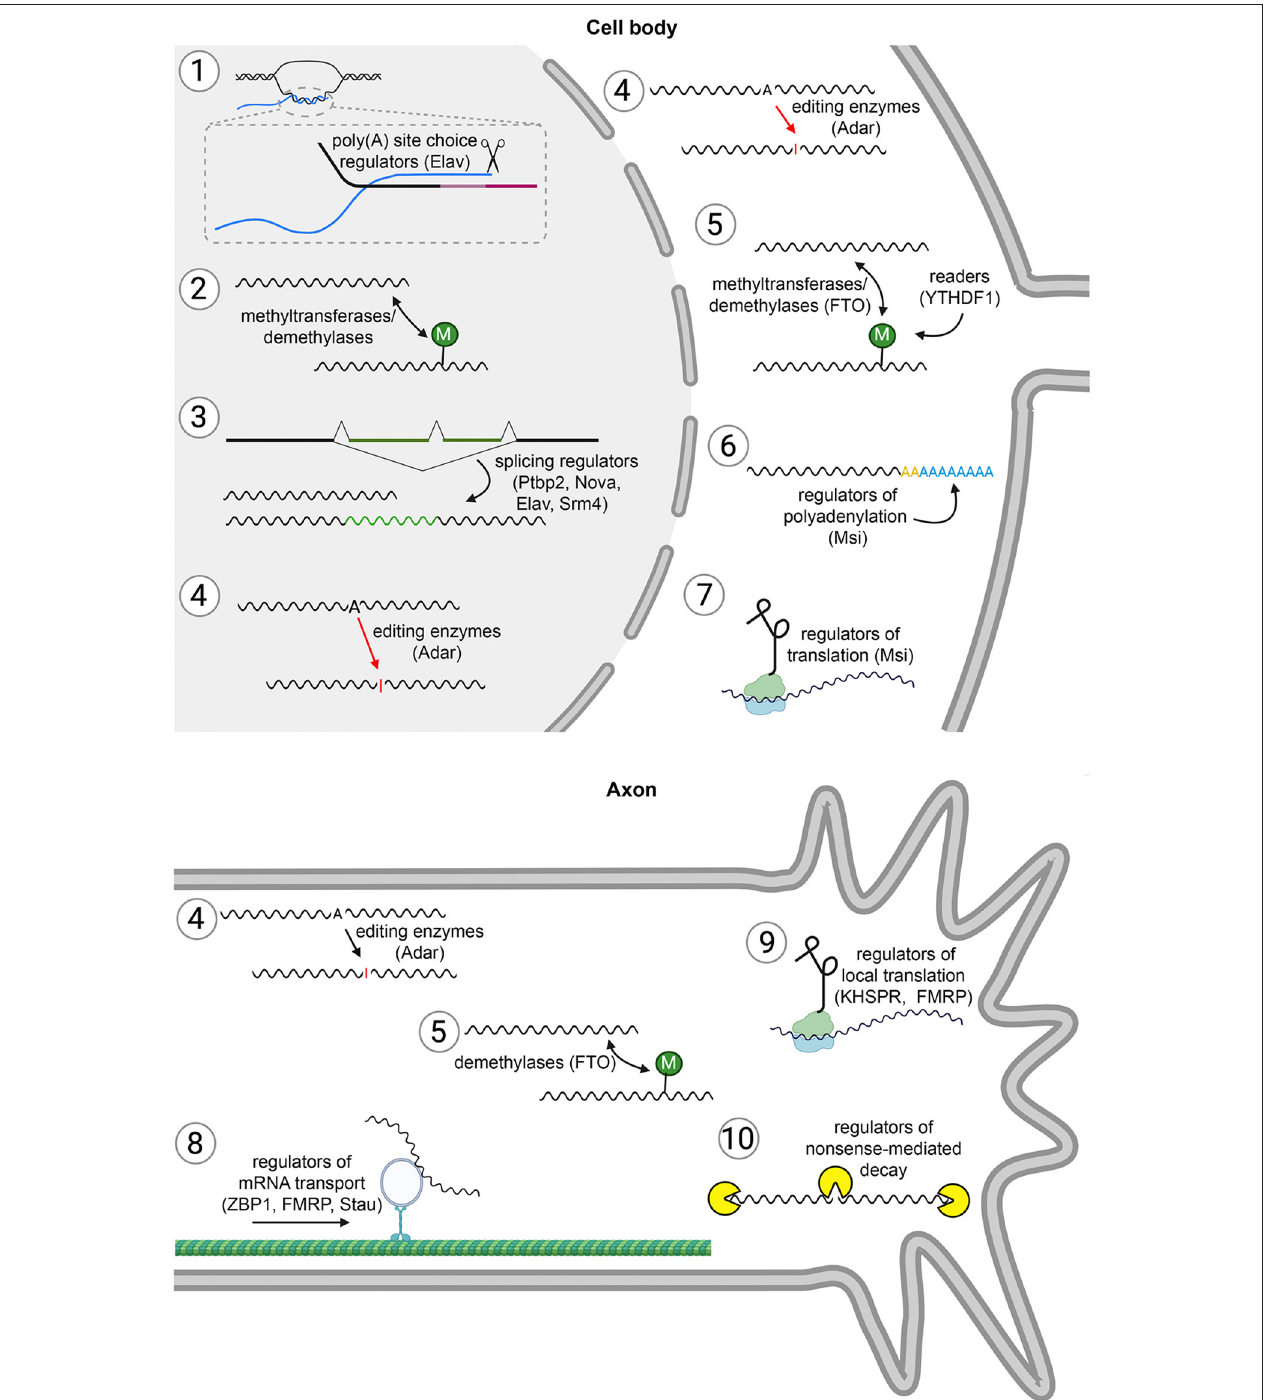
FIGURE 1 | Different steps of mRNA metabolism. (1) Alternative cleavage and polyadenylation. The choice between alternative polyadenylation signals diversifies 3 ′ UTRs and thereby determines, which regulatory motifs are included in an mRNA molecule. Thus, this process expands the potential for post-transcriptional regulation of gene expression. As in the rest of the figure, an example of an RNA-binding protein that controls the process, and which we discuss in this article, is indicated in brackets. Blue: mRNA. Shades of pink: alternative 3 ′ UTRs encoded in the DNA. (2) RNA modification. Nucleotides are modified for example by methyltransferases and demethylases. RNA modification can occur both in the nucleus and in the cytoplasm. This impacts on splicing, translation, and stability of an mRNA. (3) Alternative splicing (AS). Regulation of gene expression by AS is a means to increase proteome diversity, and also to include or exclude